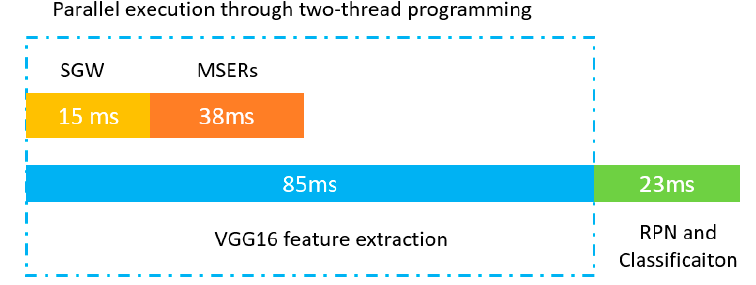
Figure 19. The system processing time.